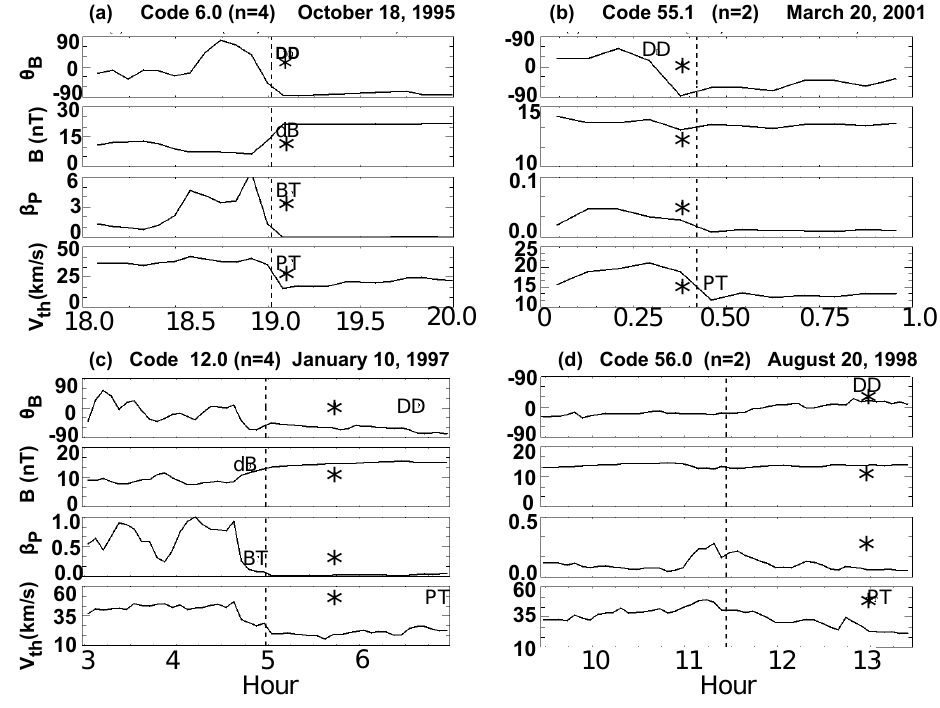
Fig. 8. Four examples of profiles of the quantities used in identifying a MC’s front boundary, for ± 3h around an earlier-determined VI boundary time (shown by a vertical dashed line). The quantities plotted are the field direction, θ B (test #1), field magnitude, | B | (test #2), proton plasma β P (test #3), and thermal speed, V Th (test #4). These MCs are: (A) DOY 291 (18 October), 1995; (B) DOY 079 (20 March), 2001; (C) DOY 010 (10 January), 1997; and (D) DOY 232 (20 August), 1998. The estimated boundary times are given by the front edge of the symbols (in the panels from top to bottom): DD (time of directional discontinuity), dB (del-field magnitude), BT (proton plasma beta), PT (proton temperature, in terms of thermal speed). The n ’s represent the number of tests passed for each case. From the individual tests a net estimate is obtained, called here the t B *-time, which is also shown as the symbol*. We can see the difference in time between the vertical dashed line (the VI time) and the t B *-time, given as 1t 1 , in each case. See Sect. 3.3 for a definitions of the VI time and 1t 1 (Eq. 2). The “Codes” are explained in the